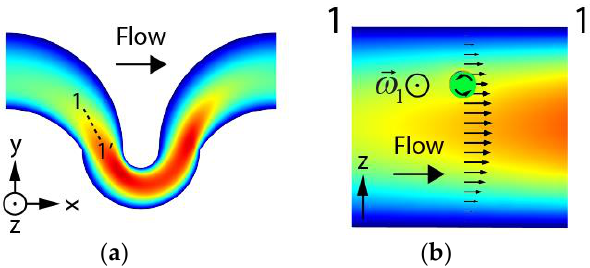
Figure 11. ( a ) Velocity magnitude at the half height of the channel; ( b ) Vertical section of the fluidic channel at the inlet region of the small curve showing the velocity magnitude distribution. The shear in the vertical direction induces an angular velocity vector, ω 1 , contained in the x-y plane pointing away from the small curve center.